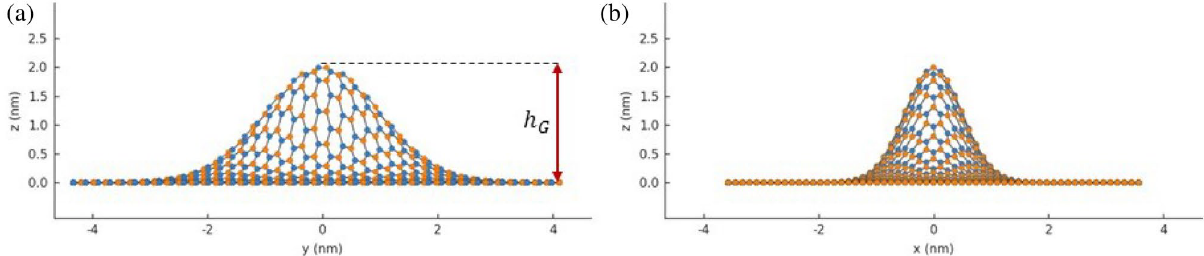
Figure 3. Profiles of elliptic Gaussian bump illustrated in Fig. 2b: ( a ) zy ; ( b ) zx